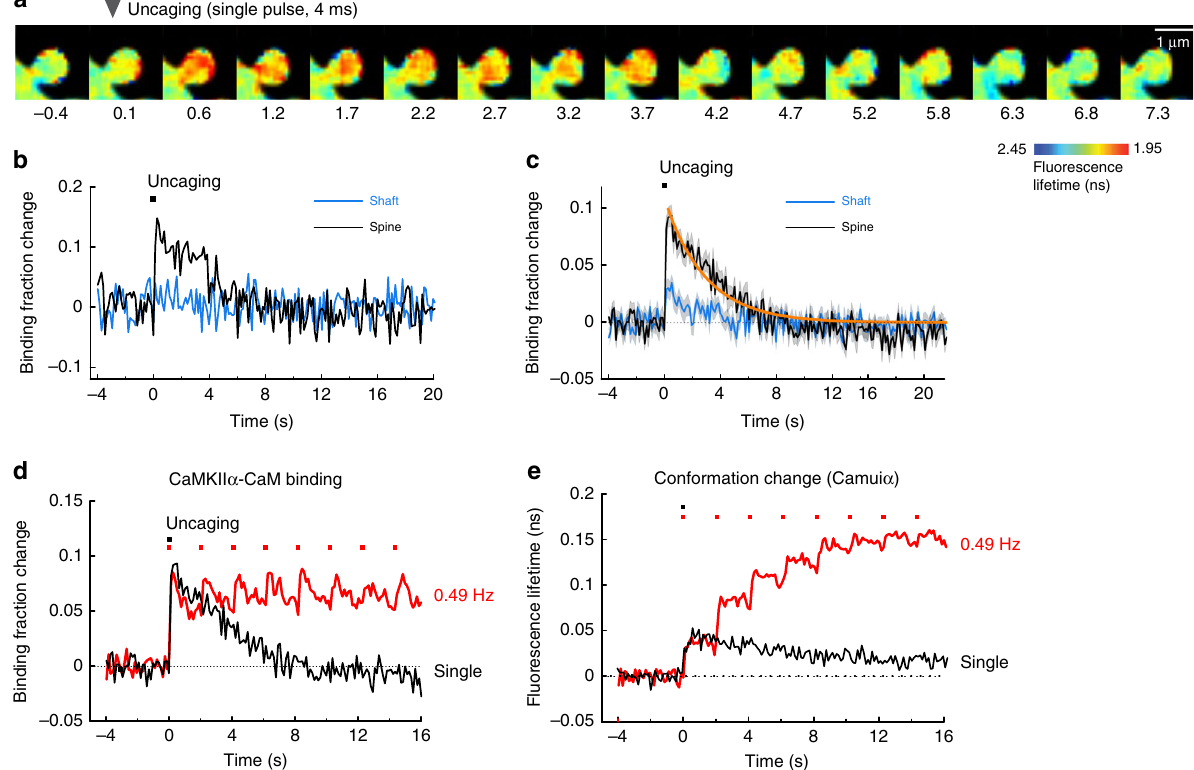
Fig. 3 CaMKII α -CaM association in response to a single glutamate uncaging pulse. a Representative fl uorescence lifetime images of CaMKII α -CaM association in response to a single glutamate uncaging pulse. Warmer colors indicate lower fl uorescence lifetime, corresponding to a higher binding fraction of mCherry-CaM to mEGFP-CaMKII α . Scale bar, 1 µ m. b Time course of CaMKII α -CaM association in a stimulated spine (black) and nearby dendritic (blue). Inset is an expanded view of the rising phase. Black squares denote uncaging pulses. Analyzed from images in a . c Averaged changes in CaMKII α -CaM association in spines and nearby dendrite ( n = 28 spines/4 neurons). The orange curve indicates the decay of binding fraction change obtained by curve fi tting of an exponential function: B ( t ) = B 0 exp( – t / τ ), where B 0 is the initial binding fraction change, τ is the dissociation time constant. The time constant is obtained as τ = 2.9 ± 0.3 s. d Comparison of CaMKII α -CaM association in response to a single pulse ( c ) and to a train of glutamate uncaging (Fig. 2d, e). e CaMKII α conformation change measured with Green-Camui α in response to a single pulse and a train of glutamate uncaging. Data from our previous publication 10 . All data are shown in mean ± sem, and sem of time constants is obtained by